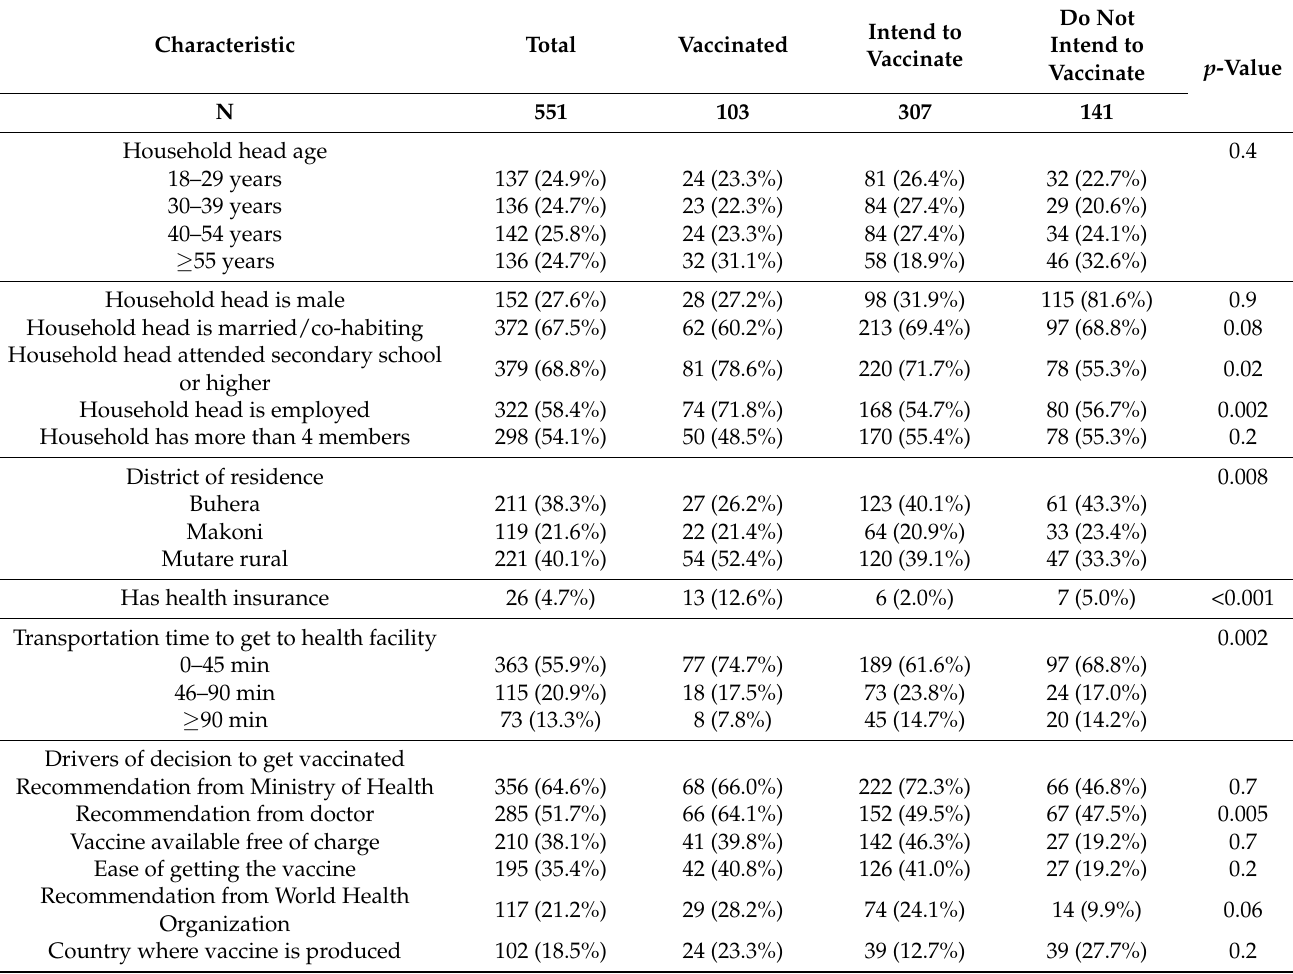
Table 1. Characteristics of households in Manicaland Province, Zimbabwe categorized by vaccination status. Characteristic Total Vaccinated